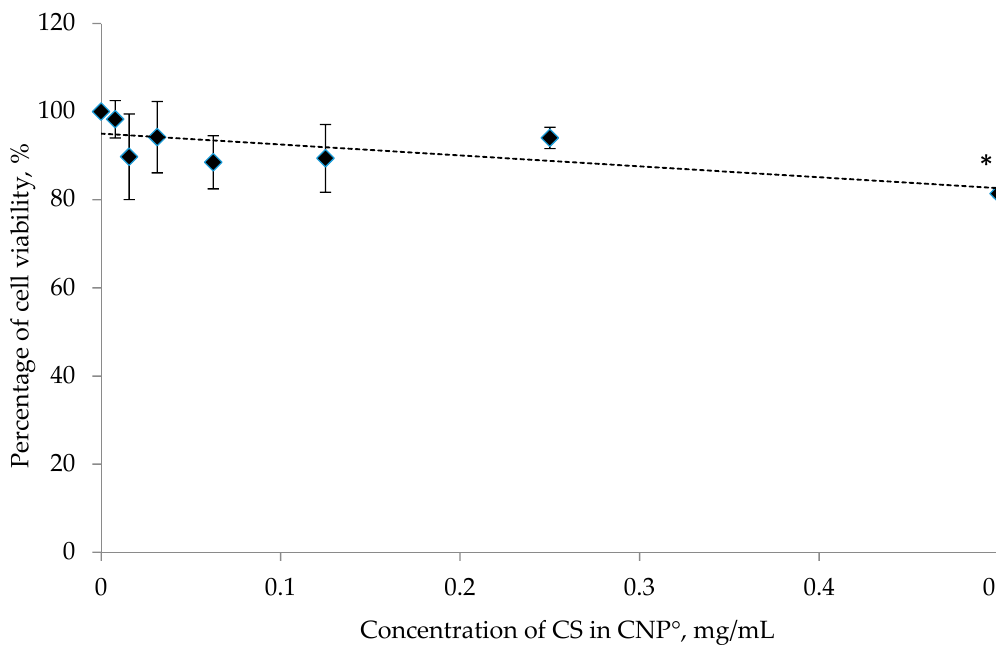
Figure 11. Flow cytometry study of in vitro accumulation of f CNP°-CGA in 786-O cells at ( C ) 30 min, ( D ) 6 h, ( E ) 24 h, and ( F ) 48 h. Overlap peaks of particular time point on ( A ) control and ( B ) FITC only peaks were shown in each figure to show the accumulation of f CNP°-CGA in 786-O cells. The accumulation of f CNP°-CGA in 786-O cells showed a time-dependent trend, indicated through the increase of fluorescent intensity over time. Accumulation of f CNP°-CGA was observed as early as 30 min ( C ) and subsequently increased 6 h, 24 h, and 24 h post treatment ( D – F ).